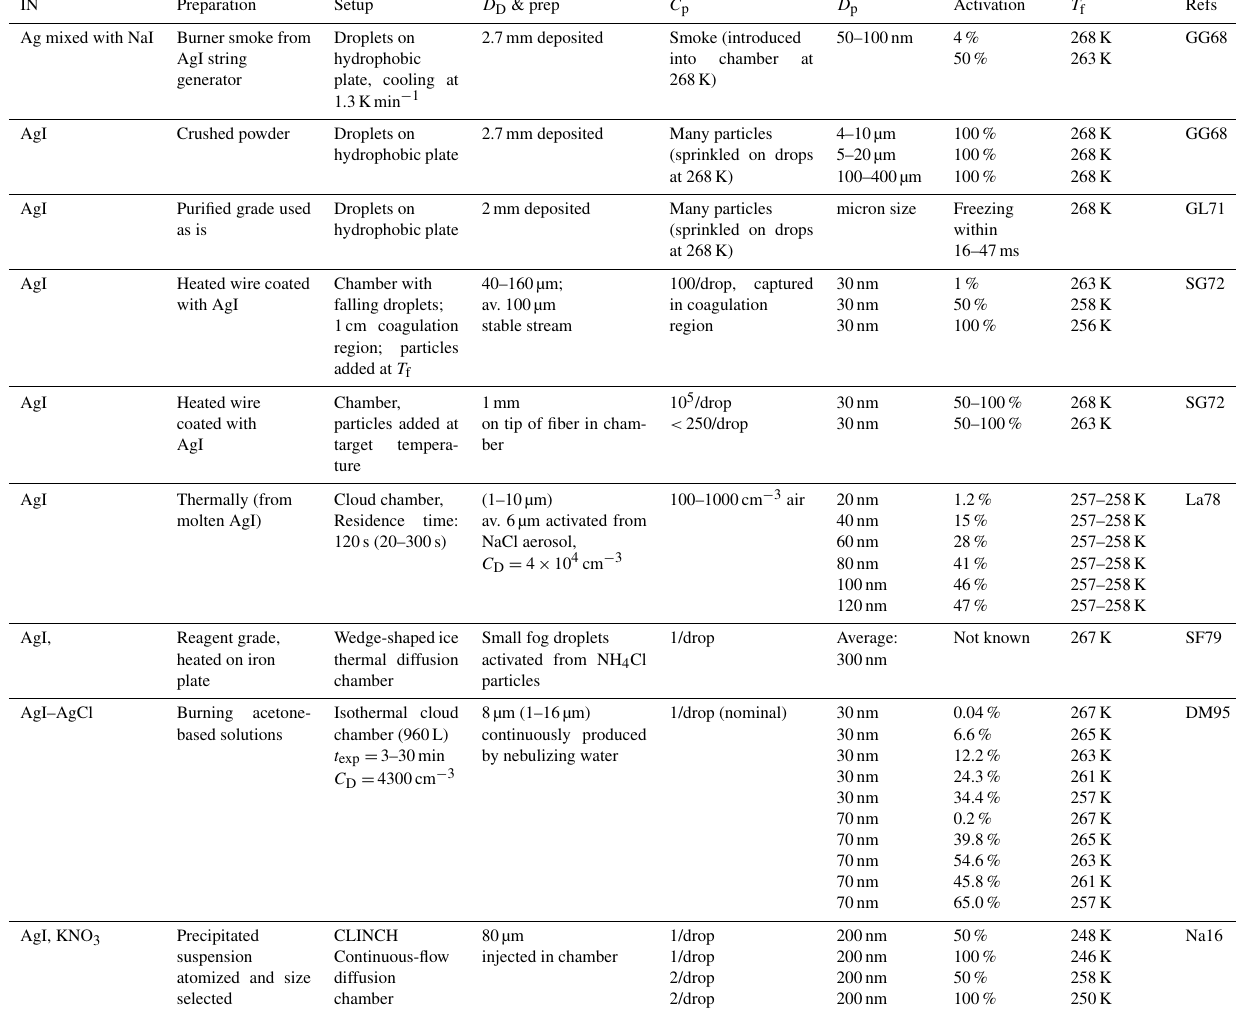
Table 2. Contact freezing studies with AgI and related salts. IN: ice nuclei; D D : droplet diameter; C p : particle concentration; D p : particle diameter; T f : freezing temperature; C D : droplet concentration. References: GG68 – Gokhale and Goold (1968); GL71 – Gokhale and Lewin- ter (1971); SG72 – Sax and Goldsmith (1972); La78 – Langer et al. (1978); SF79 – Schaller and Fukuta (1979); DM95 – DeMott (1995); Na16 – Nagare et al.